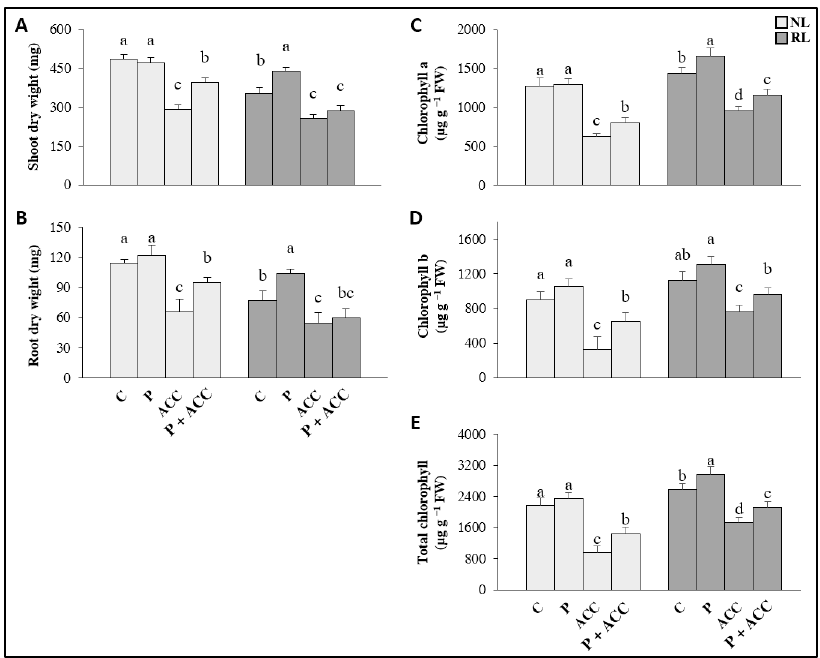
Figure 1. Effect of P. thivervalensis strain T124 inoculation and exogenous ACC on clover shoot biomass ( A ), root biomass ( B ), chlorophyll a ( C ), b ( D ) and total chlorophyll ( E ) under normal and reduced light conditions. (C, Control treatment; P, plant inoculated with P. thivervalensis strain T124; ACC, exogenous ACC; NL, Normal light condition; RL, Reduced light condition. Treatment columns in each light condition followed by different letters are significantly different ( p < 0.05). The error bar represents the standard error of the mean ( n =